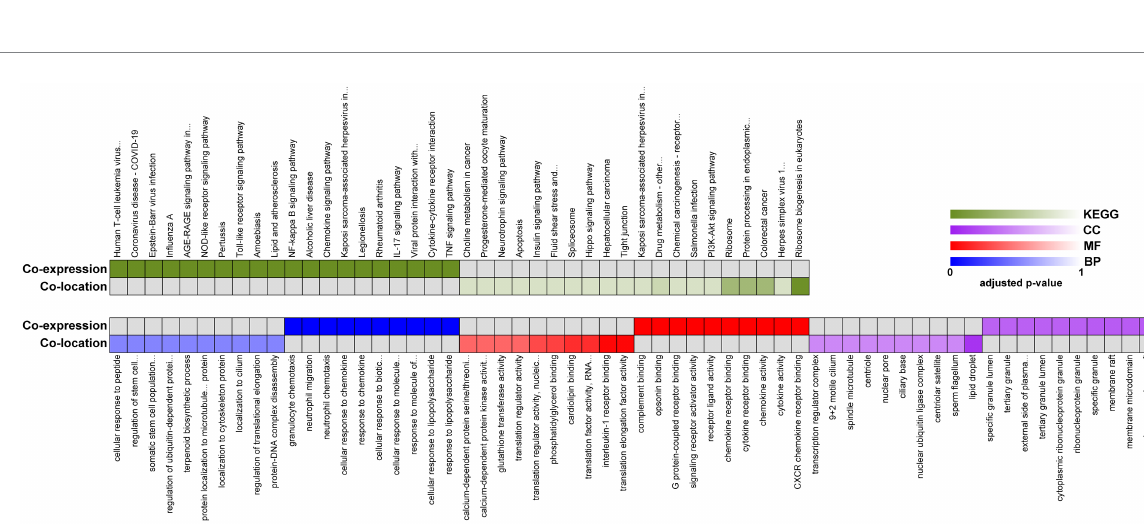
FIGURE 5 Functional enrichment analysis of identified lncRNAs between 8X and F8. Representative over-represented KEGG pathway (top) and GO terms (bottom) of gene-expression clusters. BP, biological process; MF, molecular function; CC, cellular component.